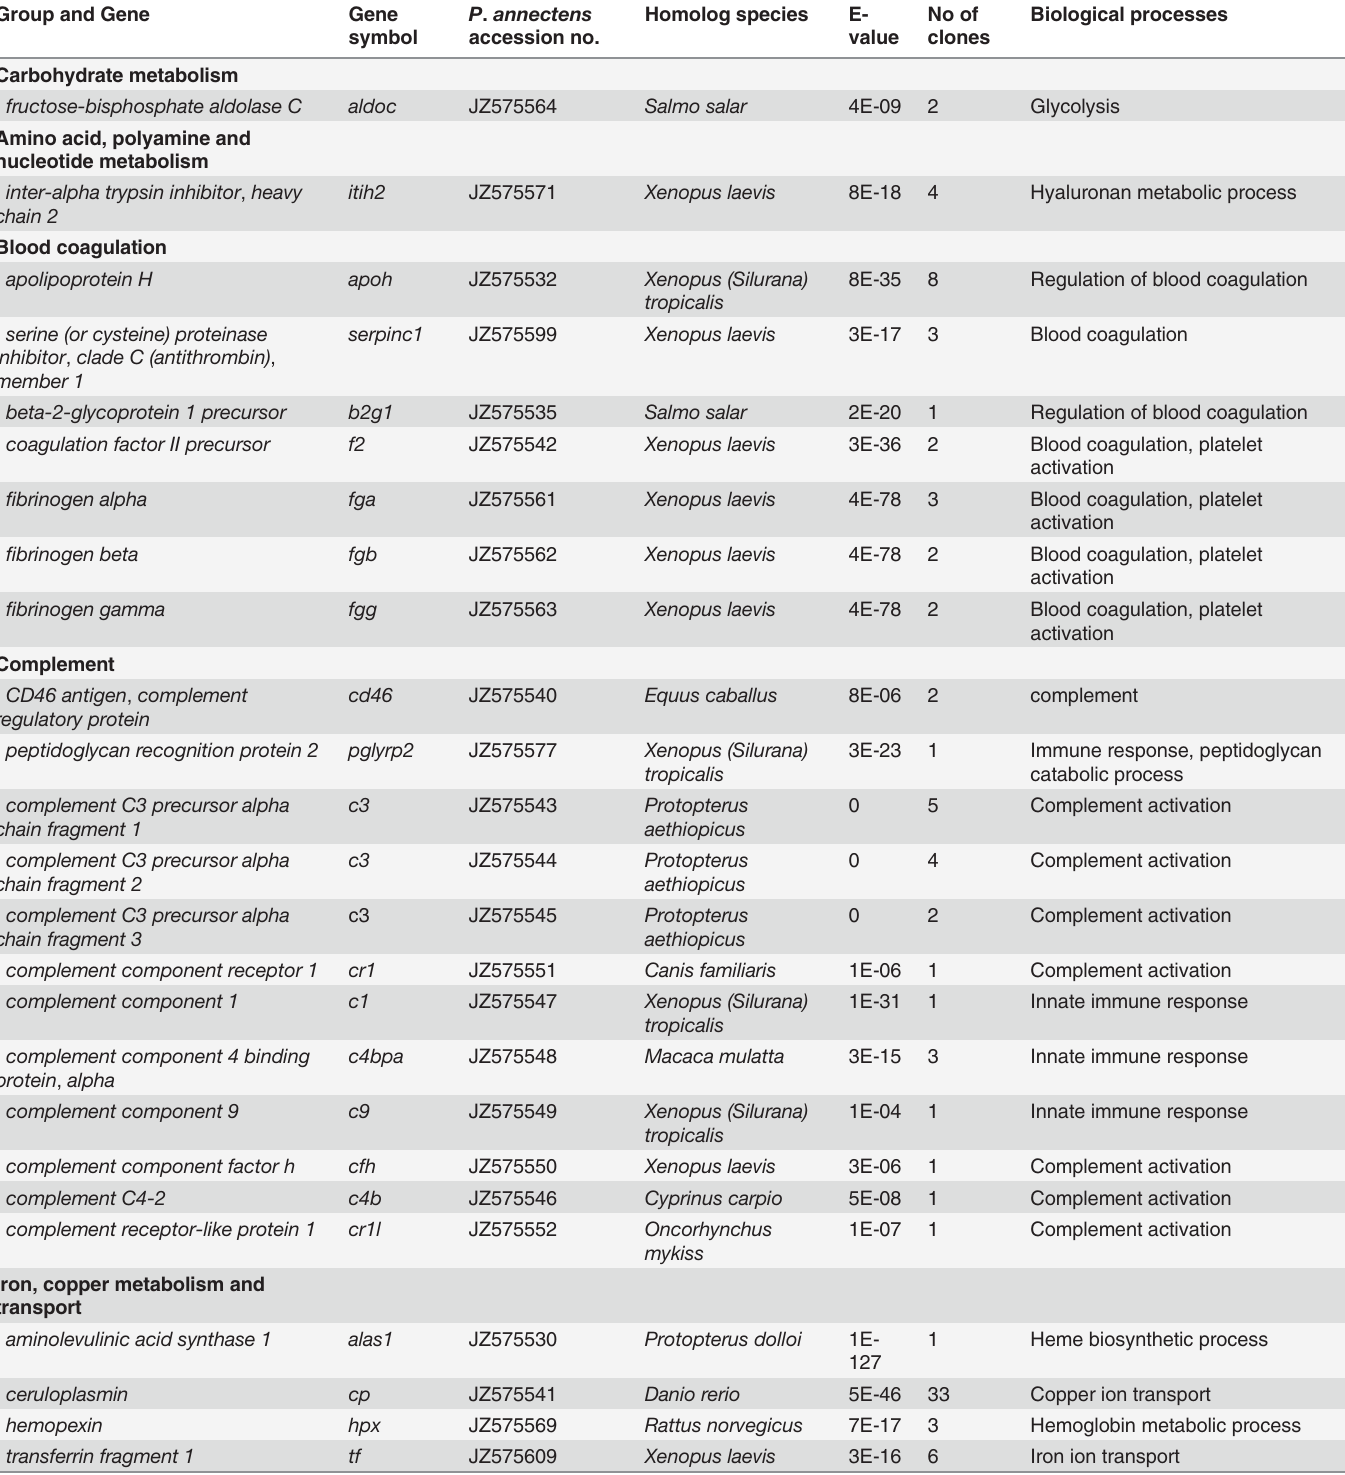
Table 3. Known transcripts found in the reverse library (down-regulation) obtained by suppression subtractive hybridization PCR from the liver of Protopterus annectens aestivated for 6 months in air with fi sh kept in fresh water as the reference for comparison. Group and